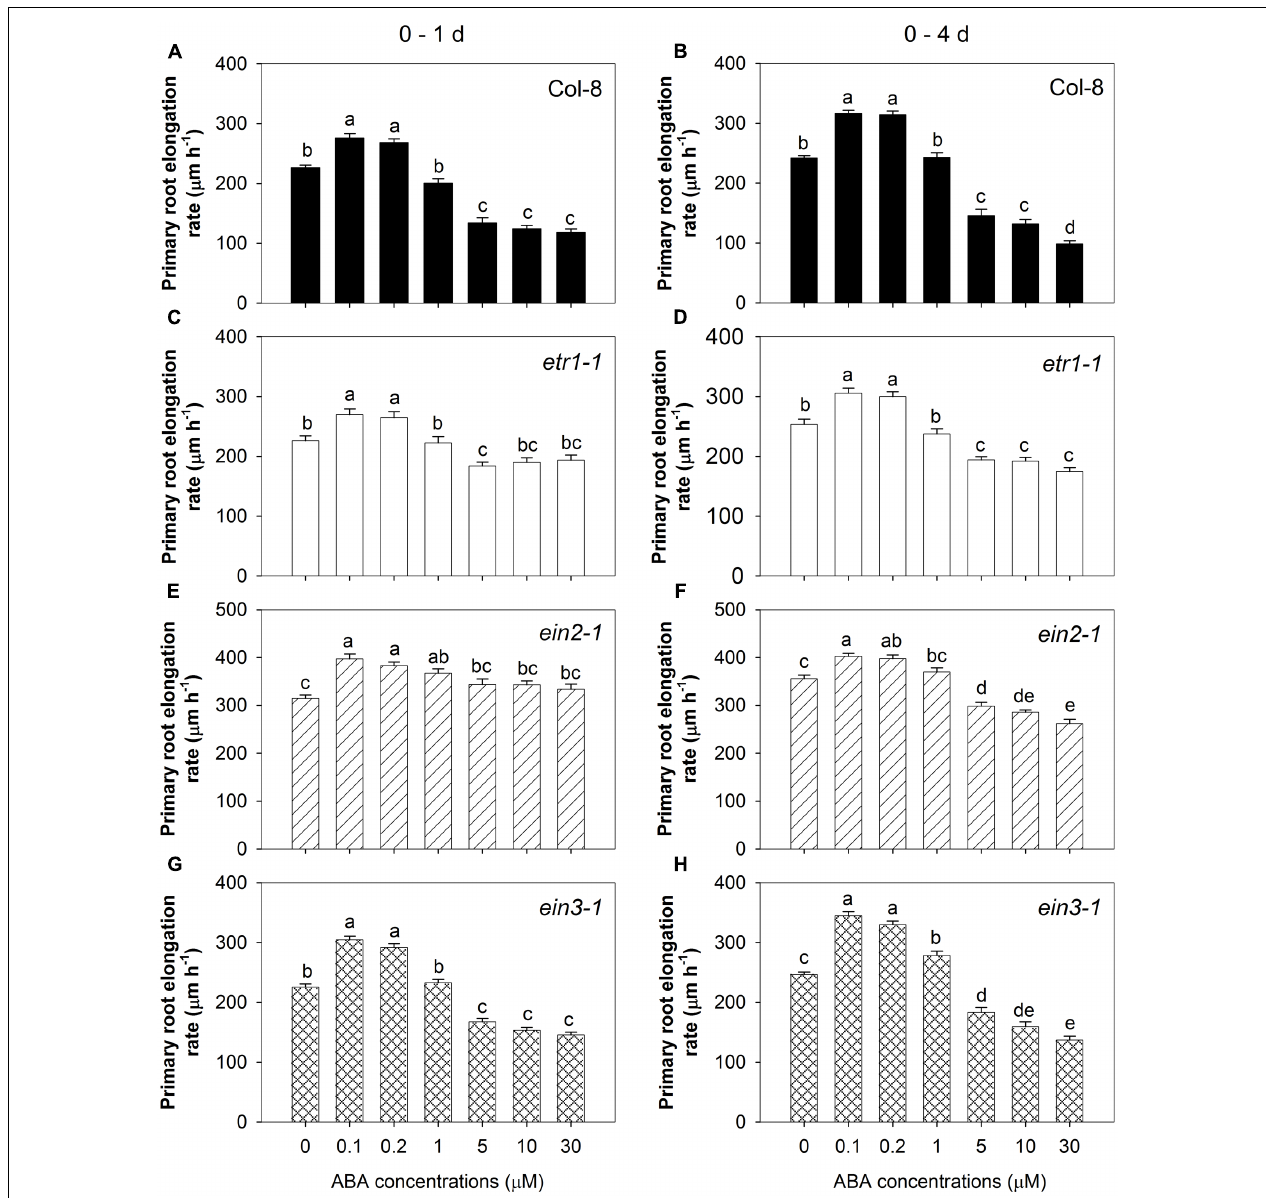
FIGURE 3 | Various responses of root growth to seven ABA treatments in three ethylene insensitive mutants and wild-type. Primary root elongation rates 1 day after treatment: (A) Col-8 wild-type; (C) etr1-1 ; (E) ein2-1 ; (G) ein3-1 , and over a 4-day treatment: (B) Col-8 wild-type; (D) etr1-1 ; (F) ein2-1 ; (H) ein3-1 . Seedlings of each line were germinated, chosen and transferred to medium with various ABA concentrations ( µ M) as described in Figure 1 . Primary root length was marked after transplanting and the increase of primary root were measured every day. The root elongation rate was calculated for 1 and 4 days after treatments on average. Only one genotype was used in each experiment ( n = 14), and results for each genotype came from combining two sets of independent experiments. All eight experiments were done consecutively from 17/07/2013 (day/month/year) to 26/08/2013. The values are means, and the vertical bars represent standard errors of the means. Data analysed using one-way ANOVA with Tukey’s post hoc test and different letters indicate significant differences among ABA treatments at P < 0.05. Eta 2 : (A) 0.773; (B) 0.842; (C) 0.333; (D) 0.635; (E) 0.237; (F) 0.660; (G) 0.810; (H) 0.827. Seedling numbers: (A) n = 28; (B) n = 21–28; (C) n = 28; (D) n =